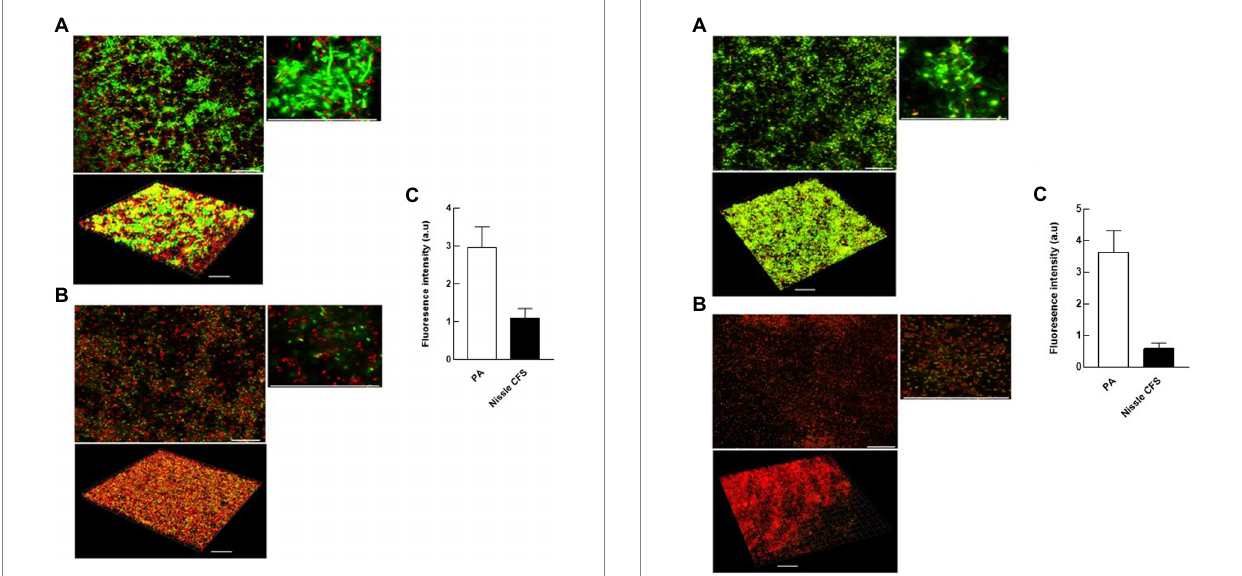
FIGURE 4 E. coli Nissle cell-free supernatant (CFS) reduces the accumulation of eDNA in developing biofilms. 2D and 3D confocal images of P. aeruginosa (PA) biofilms grown in the absence (A) and presence (B) of cell-free supernatants of E. coli Nissle. Biofilms were stained with the eDNA-specific cell-impermeant nucleic acid stain TOTO-1 (Green) and counterstained with a cell-permeant nucleic acid stain, SYTO-60 (Red). Viable cells appear red while eDNA appears green. Dead cells appear are yellow (co-localization of red and green color). (C) Quantification of fluorescence signals derived from CLSM 3D imaging indicates that the accumulation of eDNA of the matrix of P. aeruginosa biofilms was significantly reduced by incubation with Nissle cell-free supernatants. Data are means ± SEM ( n = 3). Scale bars = 30 μ m.